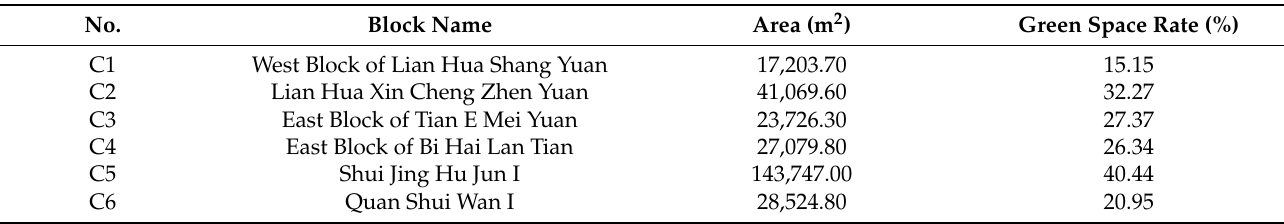
Figure 2. The study area and the case neighborhoods. Table 1. General situation of neighborhoods. Table 1. General situation of